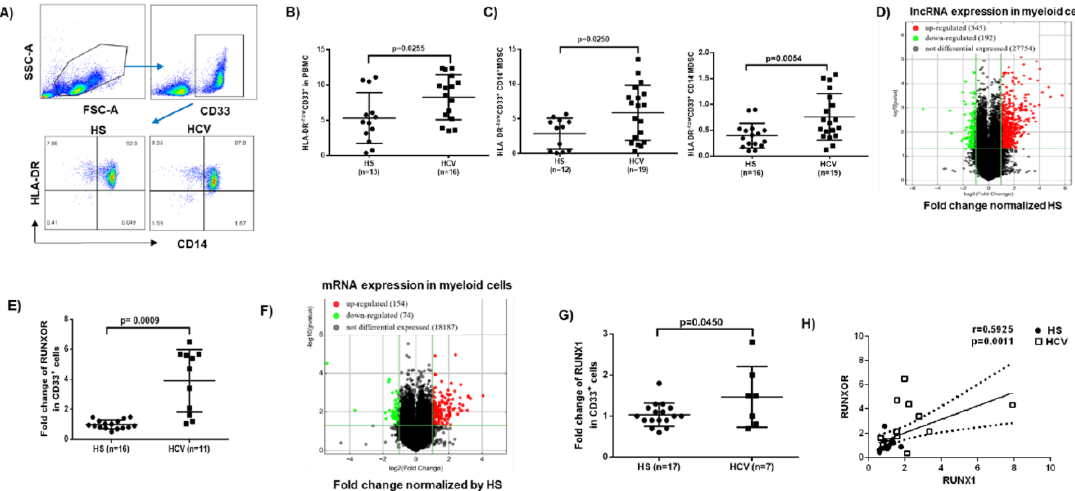
Figure 1. RUNXOR and RUNX1 are upregulated in MDSCs from HCV-infected individuals. ( A ) Representative dot plots of gating strategy for CD33 + , and then HLA-DR − and CD14 +/ − cells in PBMCs. ( B ) Expansion of immature myeloid cells (HLA-DR − / low CD33 + ). ( C ) M-MDSCs (HLA-DR − / low CD33 + CD14 + cells) and G-MDSCs (HLA-DR − / low CD33 + CD14 − cells) in PBMCs from HCV-infected individuals compared with HS, as determined by flow cytometry. ( D ) Scatter plot of the heat map of lncRNA expression in CD33 + cells isolated from HCV-infected individuals versus HS (n = 6 per group). ( E ) RUNXOR expression in CD33 + cells isolated from HCV-infected individuals versus HS, as determined by real-time RT-qPCR. ( F ) Scatter plot of the heat map of mRNA expression in CD33 + cells isolated from HCV-infected individuals versus HS (n = 6 per group). ( G ) RUNX1 expression in CD33 + cells isolated from HCV-infected individuals versus HS, as determined by real-time RT-qPCR. ( H ) Pearson Correlation analysis of RUNXOR and RUNX1 expressions in CD33 + cells derived from the same subjects.